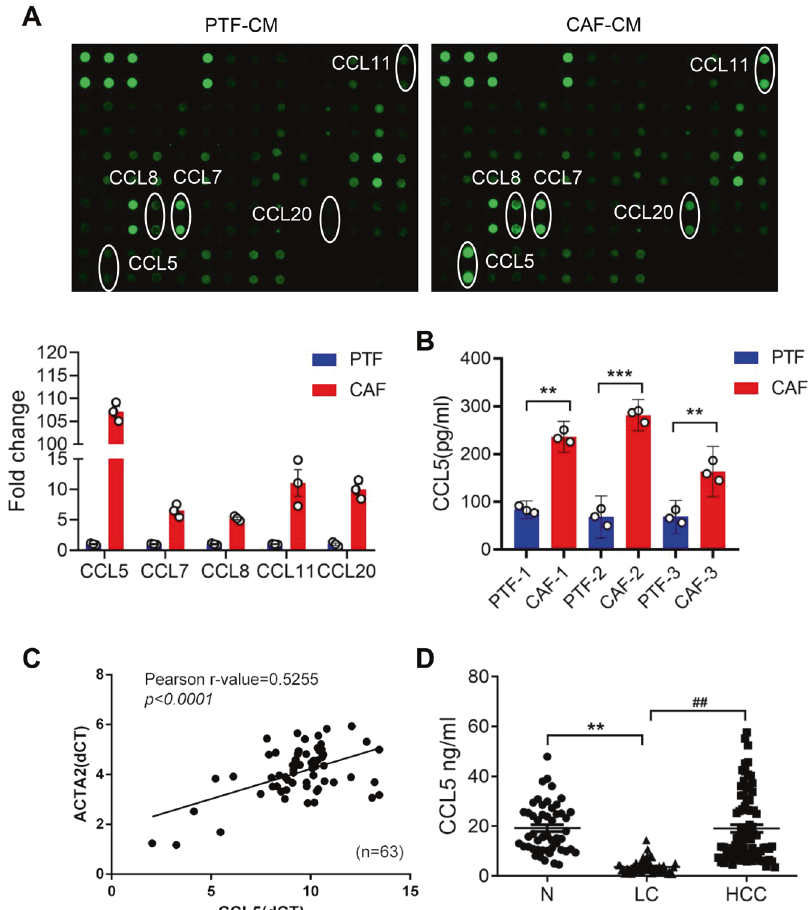
Fig. 3 Differential analysis of secreted proteins in CAFs and PTFs. A The chemokine expression of the CAF-CM and PTF-CM was examined by the cytokine array. The expression of CCL5, CCL7, CCL8, CCL11 and CCL20 was signi fi cantly increased (highlighted with a circle). B The expression of CCL5 was measured in the CM of CAFs and PTFs from three HCC patients by ELISA. Mean ± SD, ** p < 0.01, *** p < 0.001, compared with the PTF group. C Pearson correlation analysis showed that CCL5 was positively correlated with the expression of ACTA2 in 63 liver cancer samples ( r = 0.5255, p < 0.0001). D The CCL5 serum expression level of HCC patients, liver cirrhosis patients and healthy person was detected by ELISA. N = 3 per group. Mean ± SD, ** p < 0.01, compared with the healthy person group; ## p < 0.01, compared with the LC